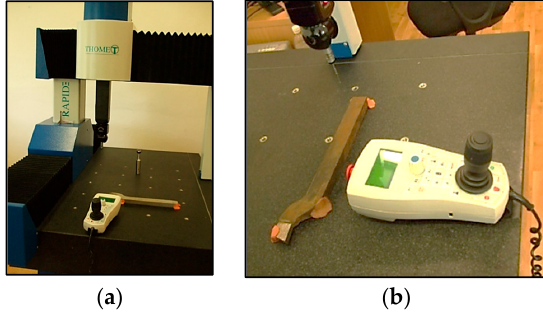
Figure 5. Preliminary tests of input angles of tool orthogonal rake γ o , ( a ) overall view of the testing equipment RAPID CNC THOME, ( b ) detailed view of the measuring of a tool orthogonal rake angle. The angle of tool orthogonal rake γ o was measured for every cutting tool used in the next experiments. The protocols from the measurements confirmed the values listed in Table 1, while the deviation of all measured values did not exceed 5% and the average angles of tool orthogonal rake for planing necking tools and straight roughing tool were γ o = 8.138° = 8°2´0´´ or γ o = 3.159 = 3°2´1´´, respectively.